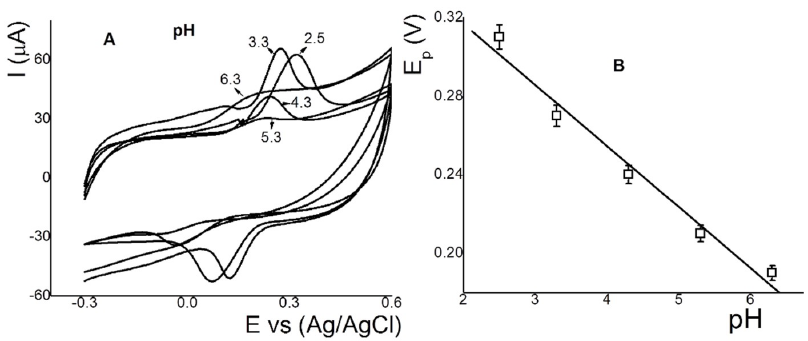
Figure 5 ( A ) Voltammograms of the effect of the pH (6.3, 5.3, 4.3, 3.3, and 2.5) for 35.0 μmol L −1 of RT, and ( B ) plots of the dependence of anodic peak potentials vs. pH for RT using IL‐CS/SPC.